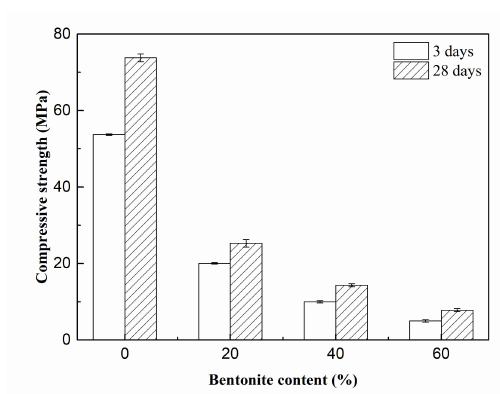
Figure 11. Dry bulk density of porous samples.